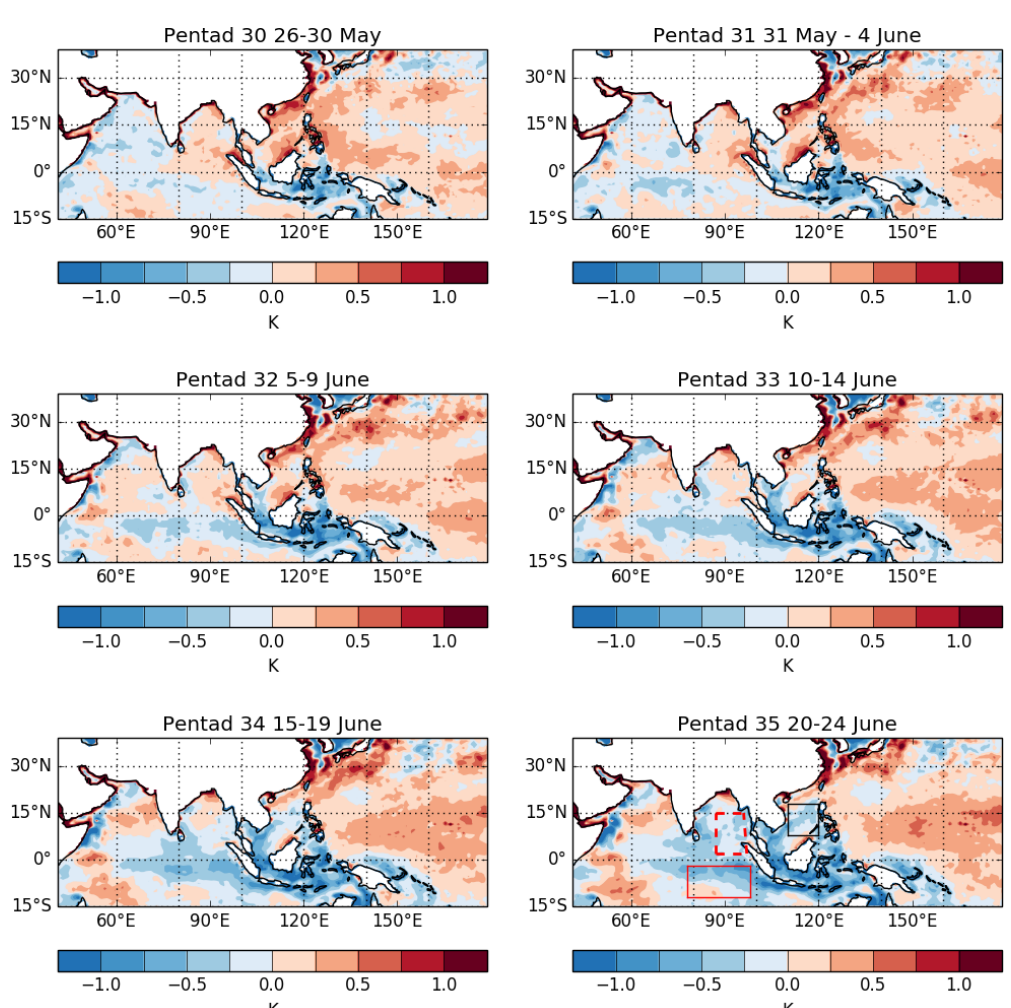
Figure 7. Development of climatological errors in SST (OISSTv2), pentad by pentad after initialisation on 25 May. The solid and dashed red and black boxes indicate the southern and northern EEIO and SCS boxes used in Fig. 8,